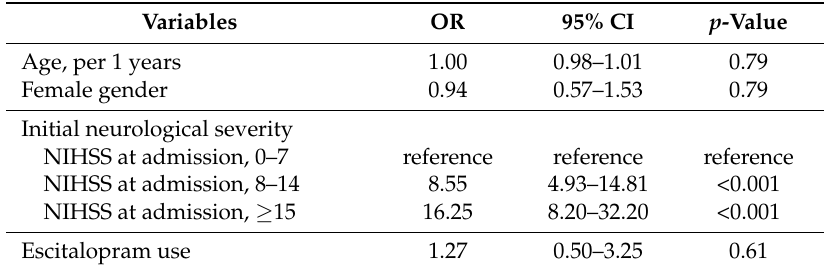
Table 3. Binary logistic regression for unfavorable short-term functional outcome, as compared to favorable outcome.